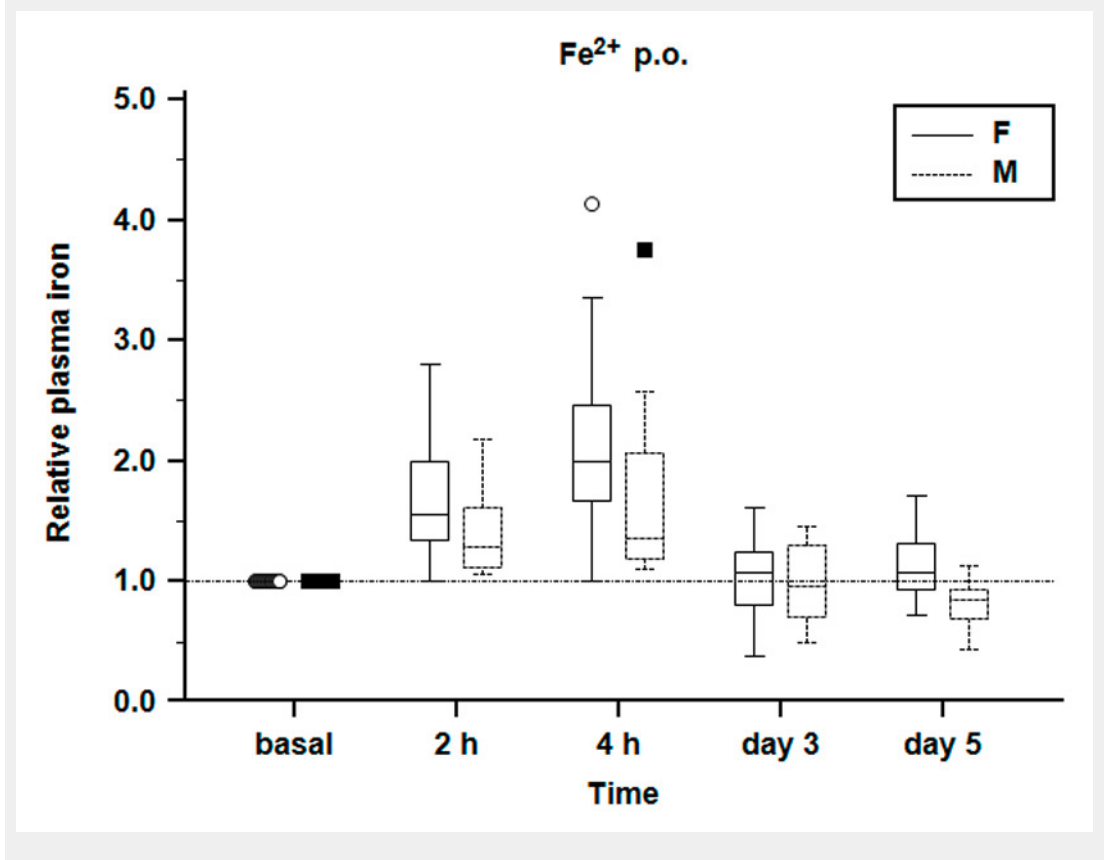
Figure 3 Relative plasma iron concentration. Relative plasma iron concentration during the first test phase. Plasma iron concentration before iron application is defined as reference = 1.0. Females show a greater relative increase of plasma iron. Plasma iron values on day 3 and 5 are comparable to initial